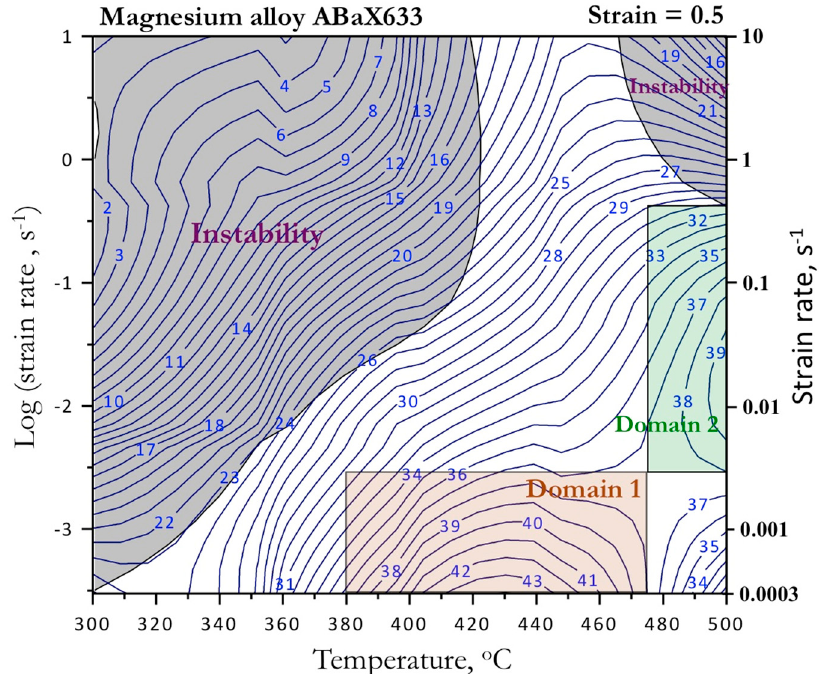
Figure 6. Processing map for the ABaX633 alloy obtained at a true strain of 0.5. The numbers associated with the contours represent the power dissipation efficiency values in percent.